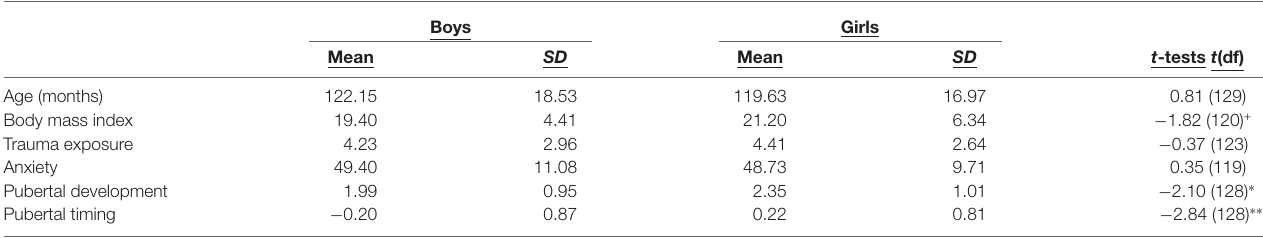
TABLE 1 | Descriptive statistics for girls ( n = 64) and boys ( n = 67) and results of independent samples t-